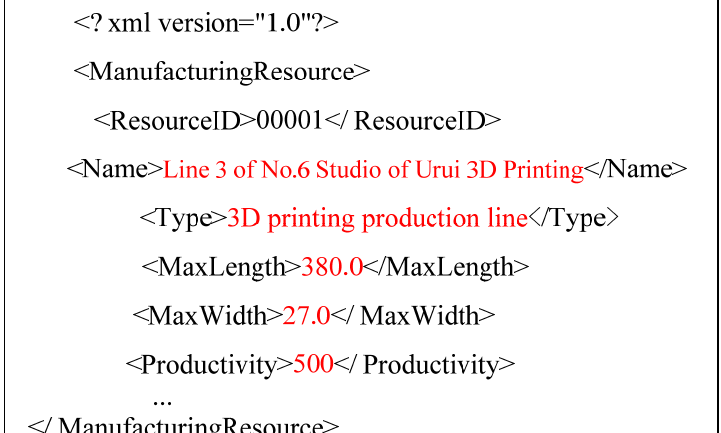
Figure 5. The description diagram of C3DPS.